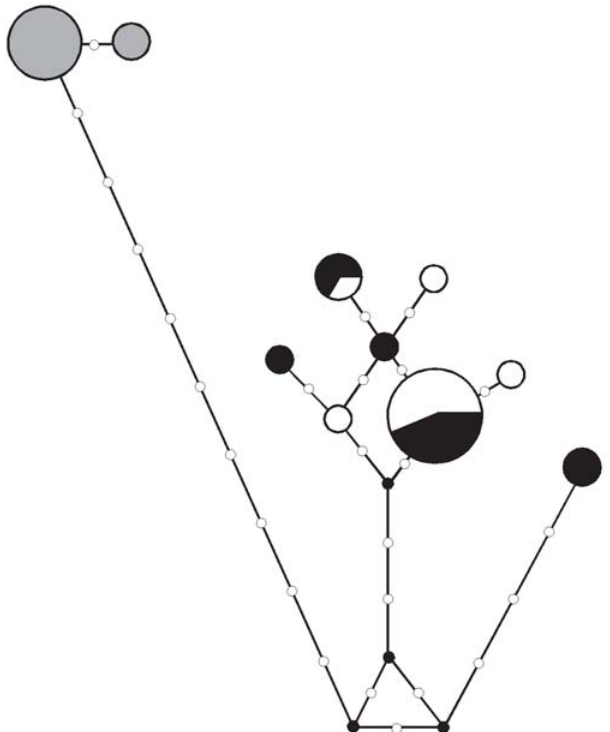
Fig. 4. Minimum spanning network of Ixinandria steinbachi haplotypes. Distances correlate to the number of mutations in the sequence as marked by open dots. Circle size corre- sponds to frequency of haplotypes. White: Juramento, black: Bermejo 1, grey: Bermejo